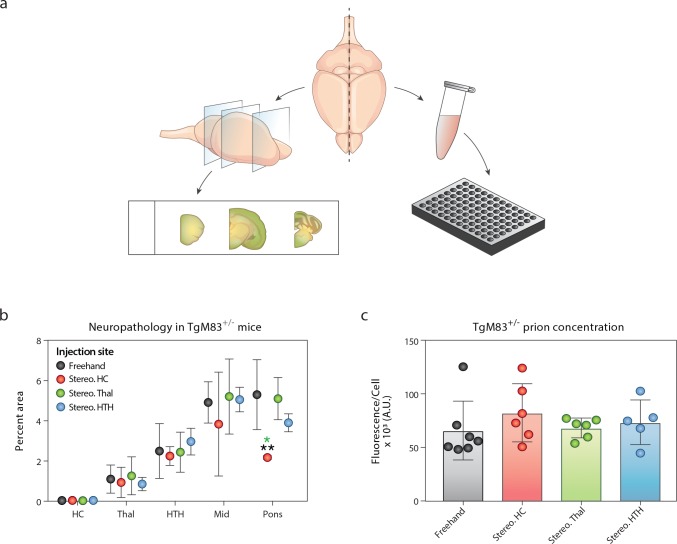
Alpha-synuclein prion concentration and neuropathology are unaltered by stereotactic inoculation in terminal TgM83+/- mice.TgM83+/- mice were inoculated with 3 μL of a 5% mouse-passaged MSA brain homogenate. Inoculations were performed either by standard freehand injection (black) or by stereotactic inoculation into the hippocampus (Stereo. HC; red), thalamus (Stereo. Thal; green), or hypothalamus (Stereo. HTH; blue). (a) After the mice developed progressive neurological disease, the animals were euthanized and their brains were harvested. One half of each brain was fixed in formalin, cut, and immunostained for phosphorylated α-synuclein neuropathology (data in panel b). The other half was flash frozen, homogenized, and tested for α-synuclein prions in the α-syn140*A53T–YFP cell assay (× 103 A.U.; data in panel c). (b) Regardless of inoculation method or site, α-synuclein pathology measured in the HC, Thal, HTH, Mid, and pons was consistent across all four inoculation groups. (c) The α-synuclein prion concentration was consistent in terminal animals. * = P < 0.05; ** = P < 0.01.